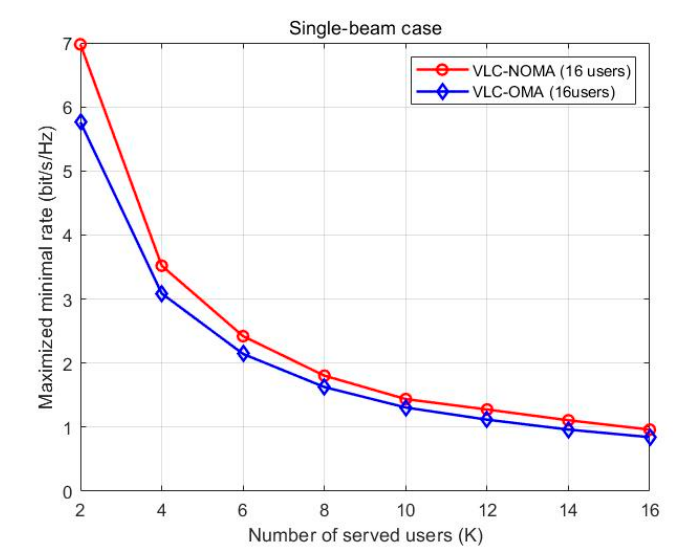
Figure 6. Maximized minimal rates of all users without QoS constraints.